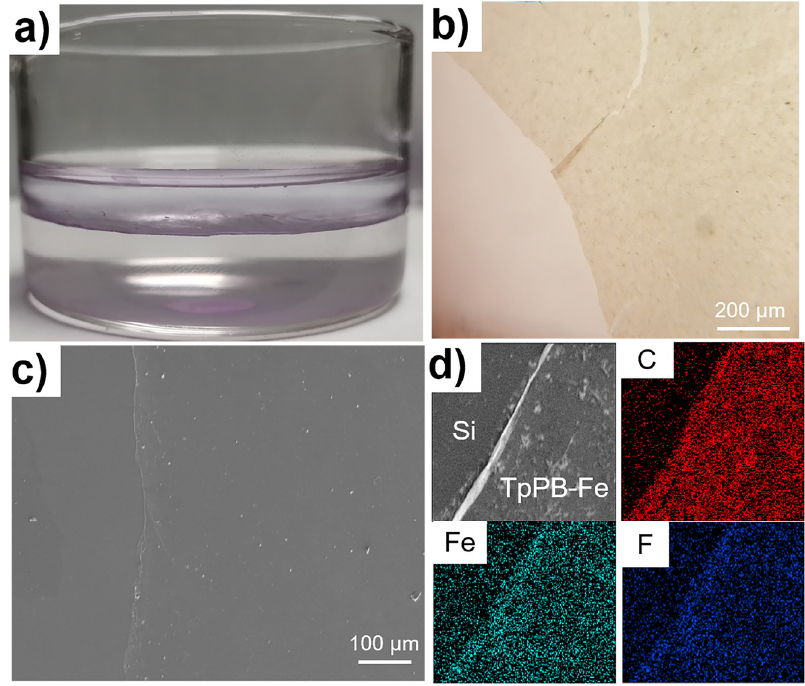
Figure 2. ( a ) The interfacial polymerization of TpPB-Fe coordination polymer between CH 2 Cl 2 /H 2 O; ( b ) Optical image, ( c ) SEM image, and ( d ) EDX-mapping of TpPB-Fe.